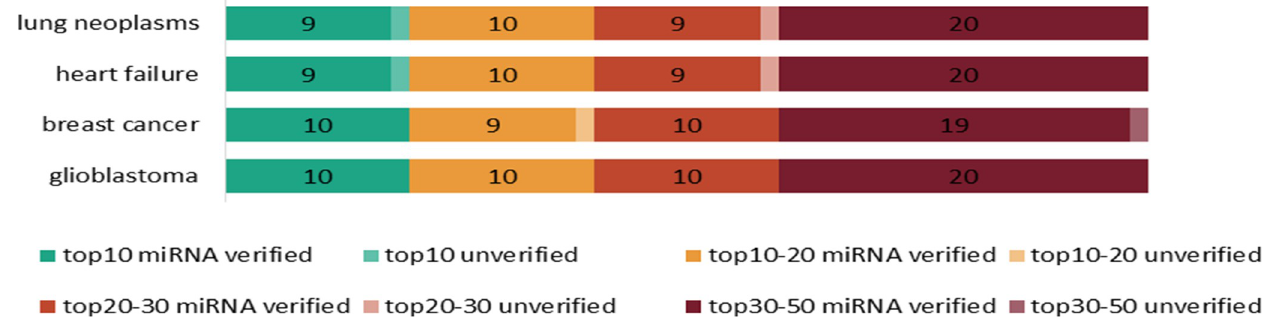
Fig 9. The number of predicted miRNAs verified in HMDD v3.0 by our model, including different top intervals.